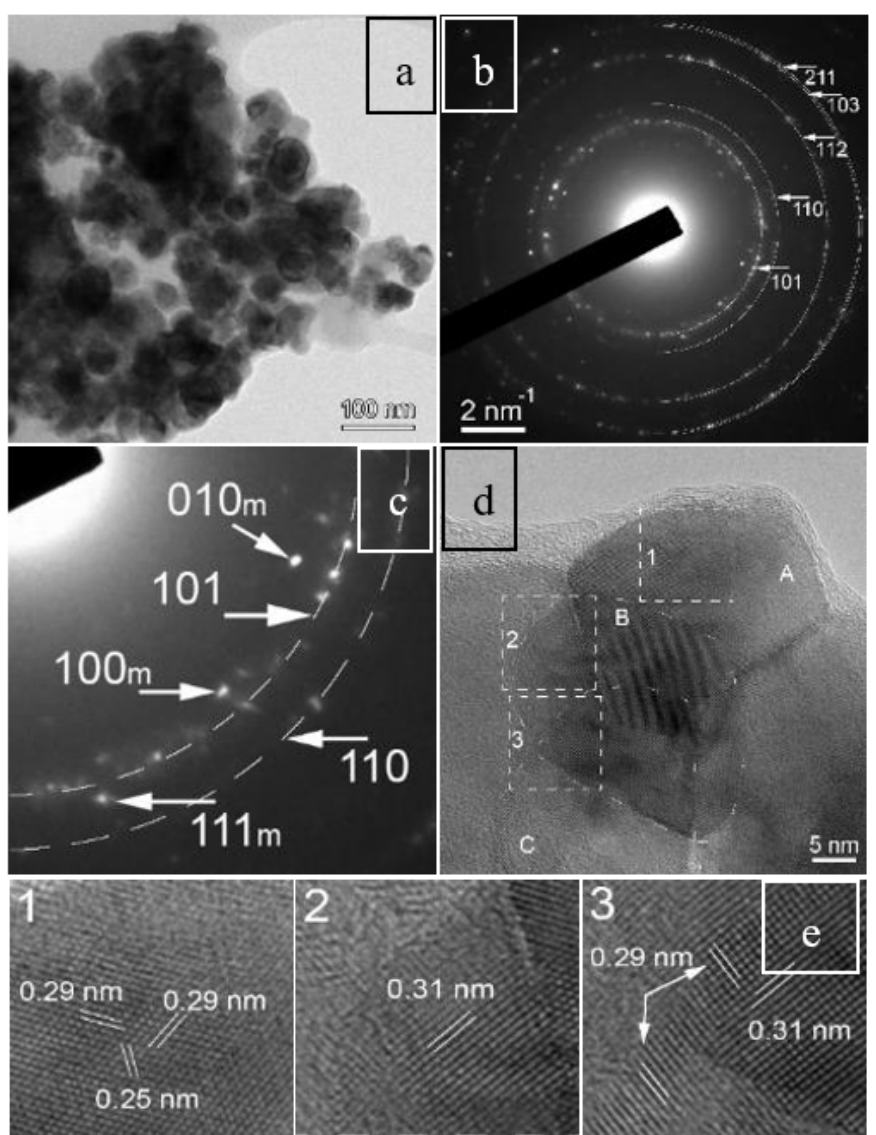
Figure 2. ( a ) TEM image showing typical wet impregnated 10Eu(I)–ZrO 2 (OW) nanoparticles with a size below 50 nm. ( b , c ) Corresponding SAED pattern and an enlarged part of it proving the formation of the ZrO 2 tetragonal dominant phase and of a minor monoclinic phase. ( d ) HRTEM image and ( e ) zoomed-in images from three different areas confirming the occurrence of a minor monoclinic phase.